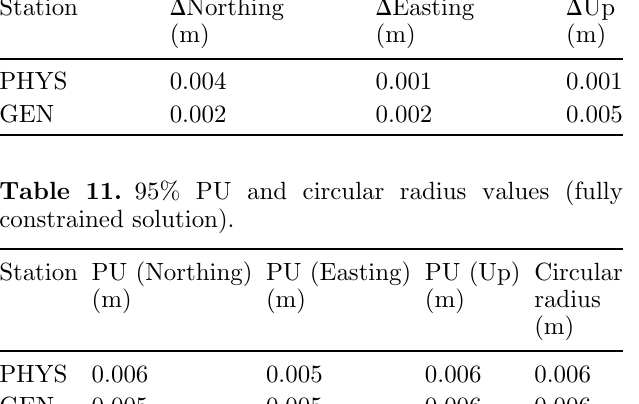
category of Table 1 (i.e. SU < 20 mm).